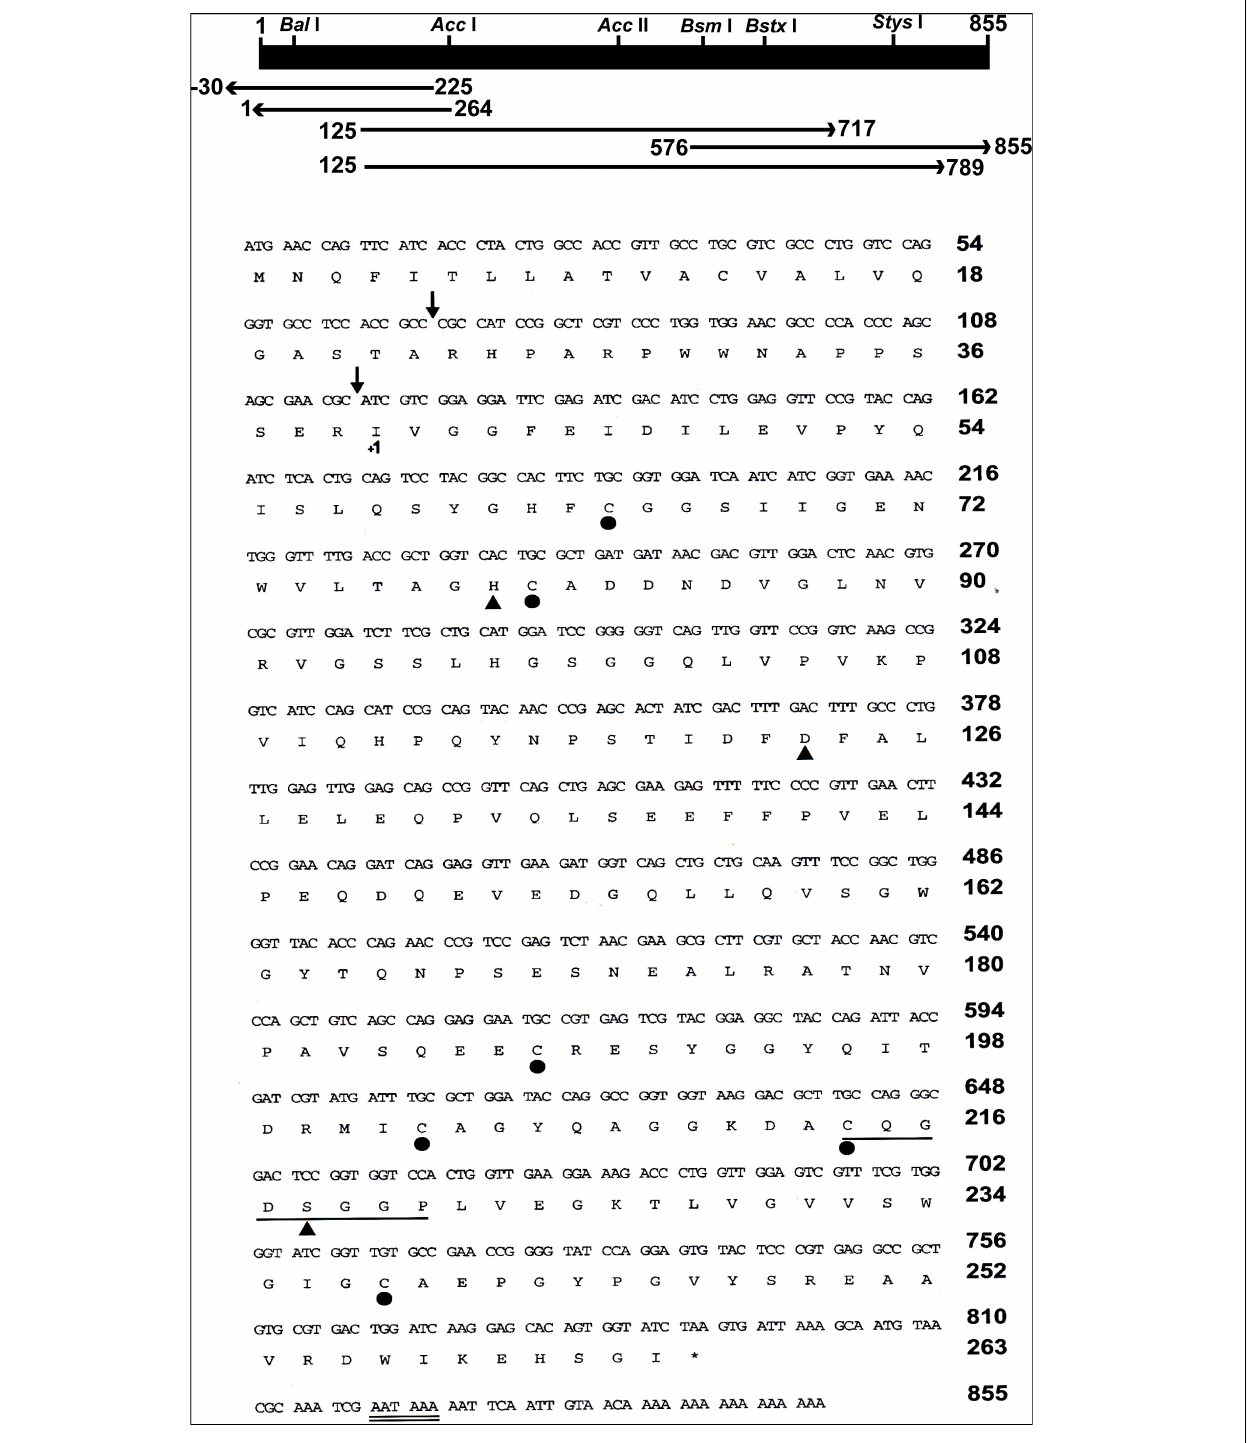
Frontiers in Physiology |